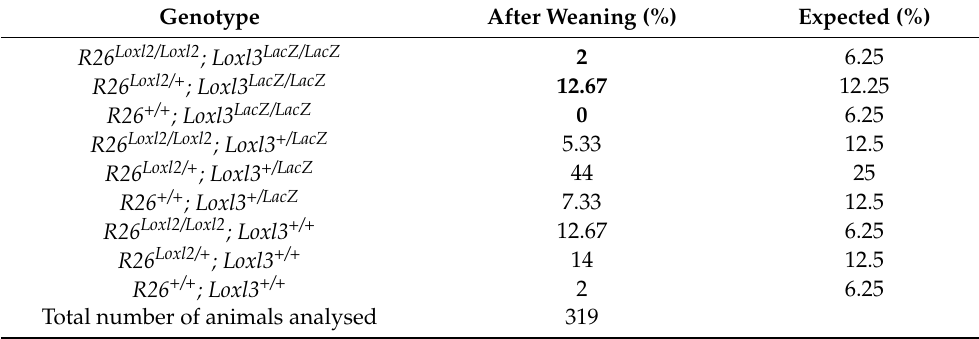
Table 4. Genotype frequency of offspring from R26 Loxl2 /+ ; Loxl3 +/ LacZ crossings. Values reflecting the suppression of the embryonic lethality associated with Loxl3 KO are indicated in